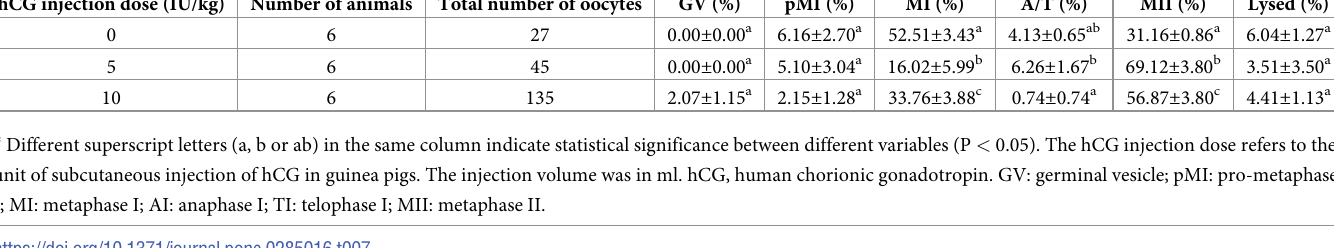
Table 7. Effects of different doses of hCG on the IVM rate of oocytes from superovulated guinea pigs. hCG injection dose (IU/kg) Number of animals